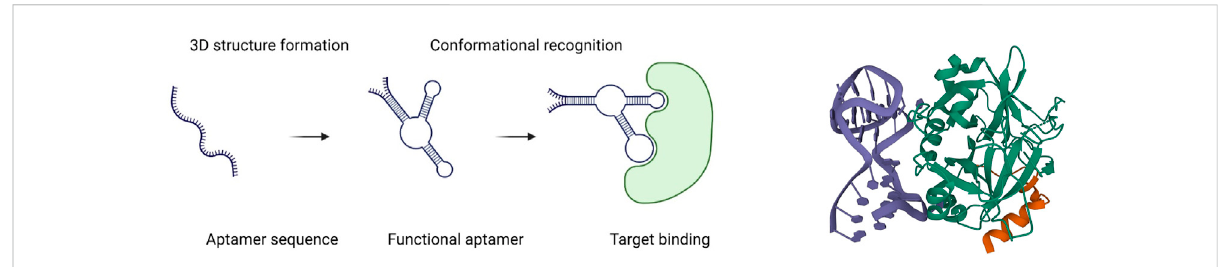
FIGURE 1 Schematicdiagramofanaptamerbindingtoatarget(left)(SunandZu,2015);3Dstructureofa27-meraptamerandthrombin(right).Aptameris shown in deep blue, and thrombin, in green (Russo Krauss et al., 2013).